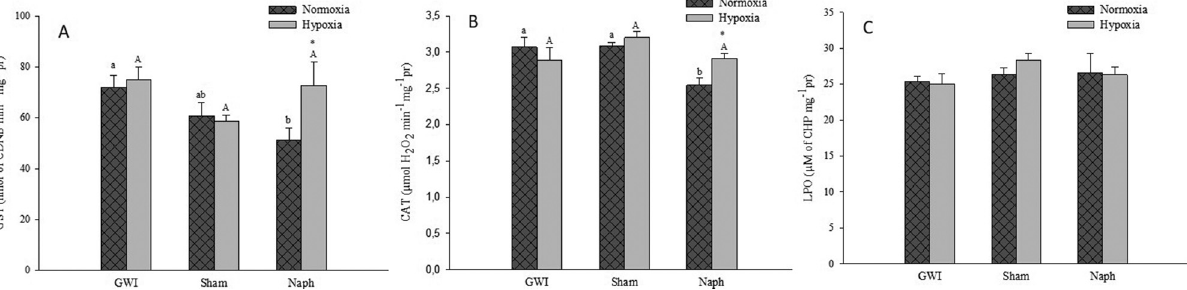
Figure2 -GST(A)andCAT(B)activityandlipoperoxidation(LPO)(C)intheliverof C.macropomum inthethreeexperimentalgroups:GroupWithout Injection (GWI), Group with corn oil injection (Sham); and Group with naphthalene injection (Naph) after 96 h normoxia exposure followed by 6 h of hypoxia. Small caps letters (a and b) indicate differences among treatments in normoxia. Capital letters (A and B) indicate differences among treatments in hypoxia. *Indicates differences between normoxia and hypoxia at the same treatment. Significance level of the Tukey test was p <0.05.